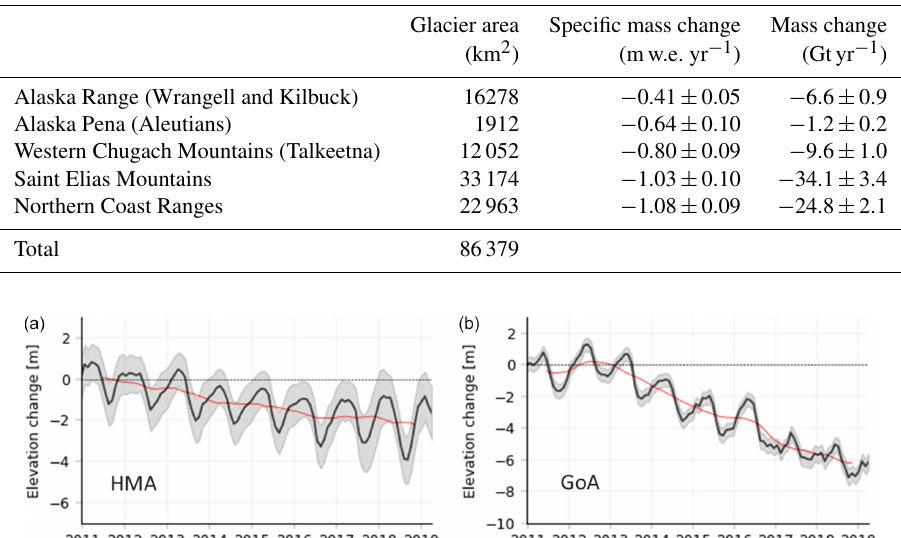
Table 2. Gulf of Alaska (GoA) mass balance trends from July 2010 to July 2019, aggregated on the Randolph Glacier Inventory (RGI 6.0) sub-regions.